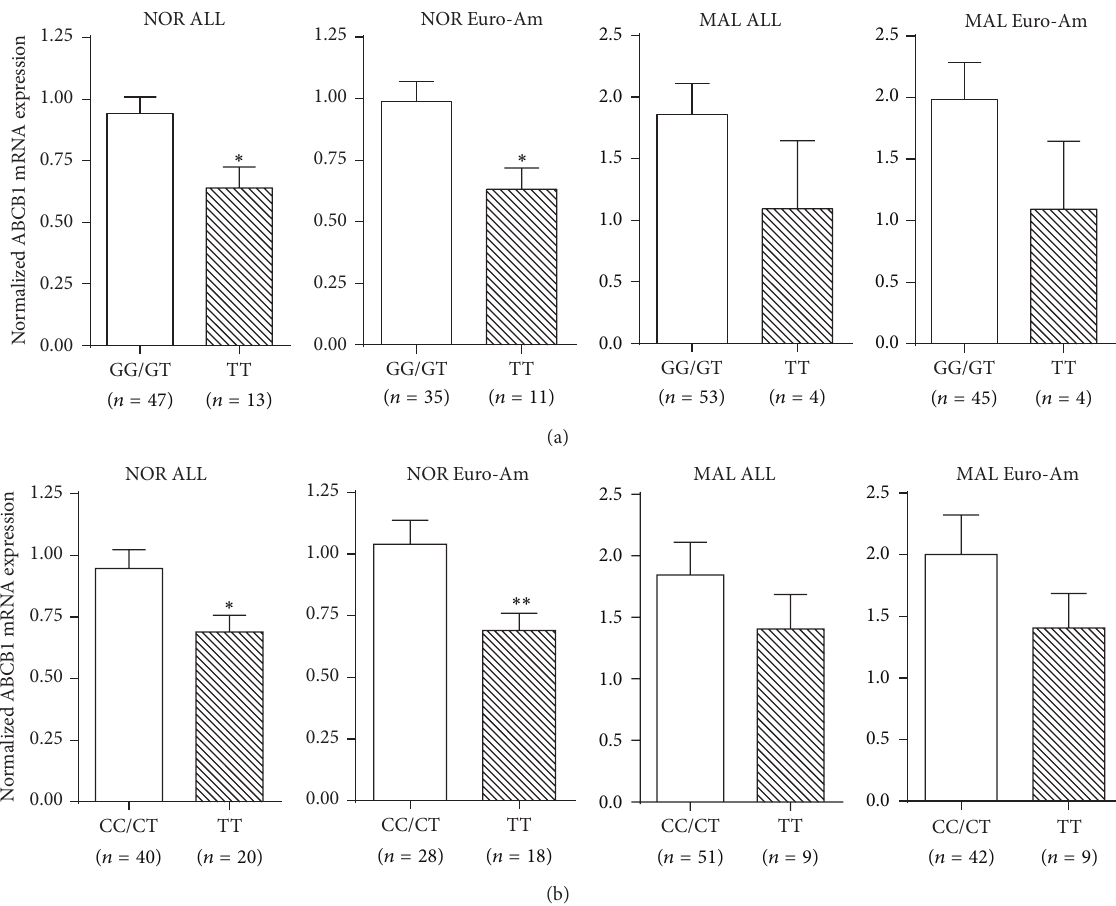
Figure 2: Expression of ABCB1 based on genotypes. The mRNA expression of ABCB1 in mutant homozygotes of G2677T (a) and C3435T (b) was compared to the wild-type homozygotes and heterozygotes in both whole study population (ALL) and the European Americans (Euro-Am). Values are expressed as means ± SEM, ∗ 𝑃 < 0.05 , and ∗∗ 𝑃 < 0.01